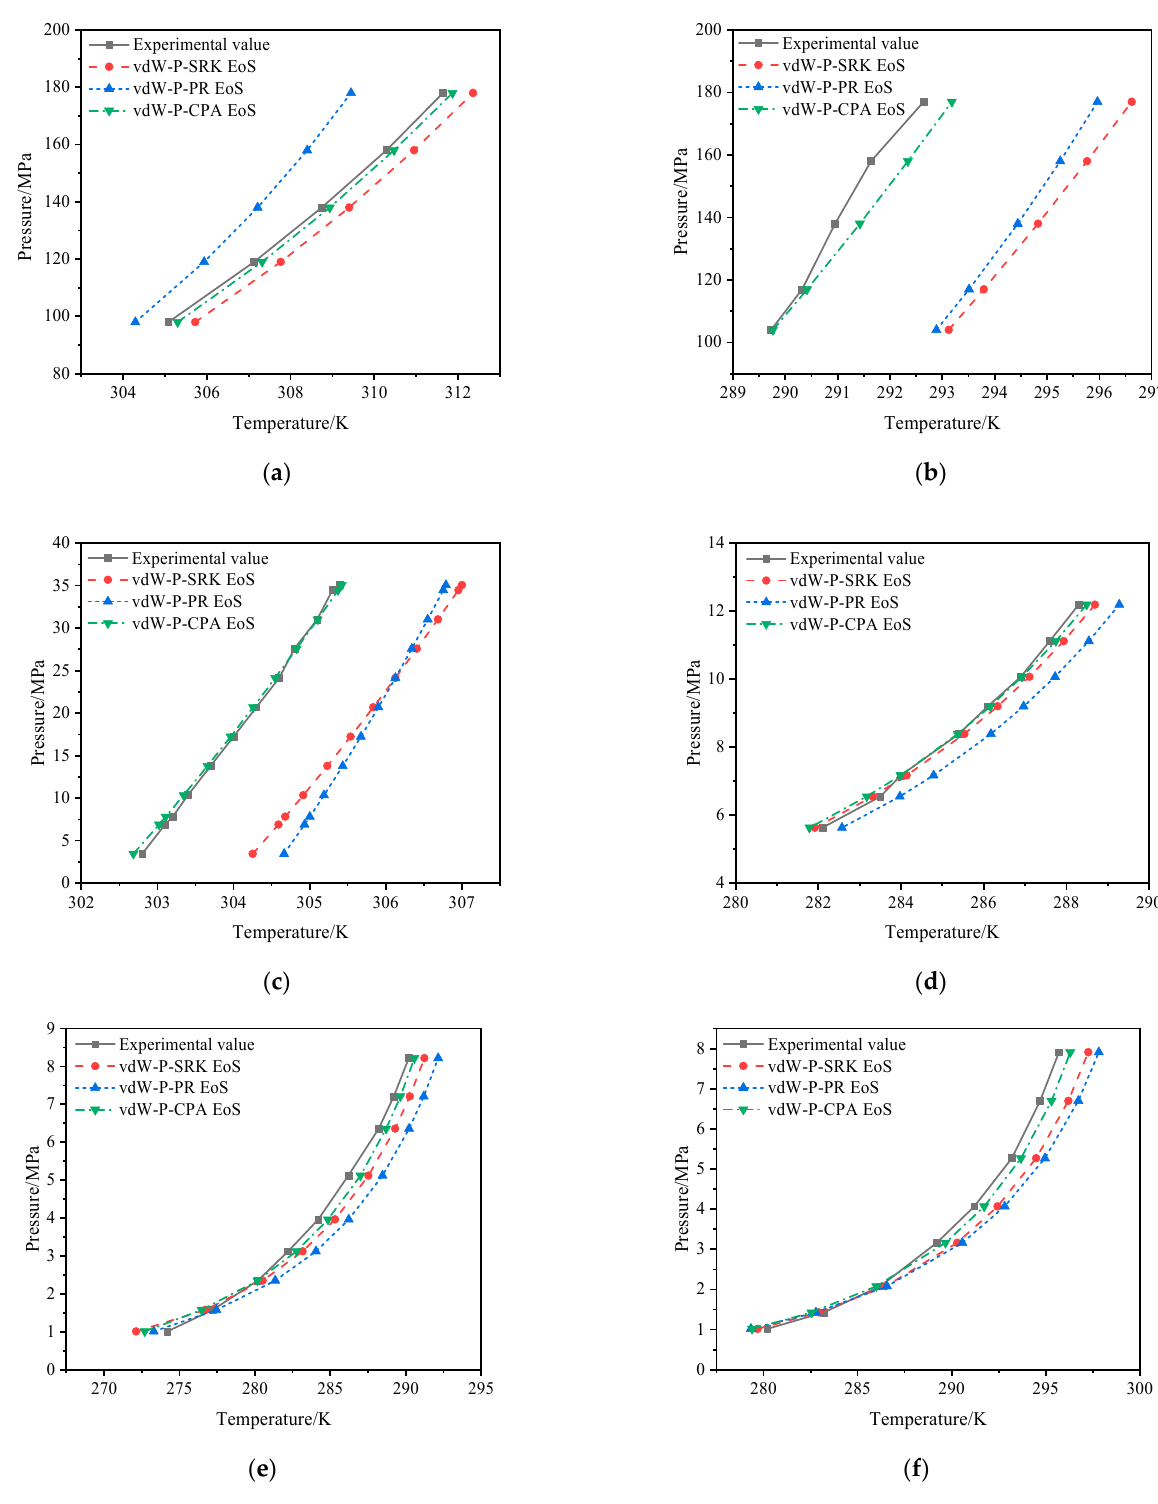
Figure 1. Comparison of hydrate formation conditions predicted based on different models and experimental values for: ( a ) CH 4 -water system; ( b ) CO 2 -water system; ( c ) H 2 S-water system; ( d ) multicomponent systems (0.05 mol% H 2 S); ( e ) multicomponent systems (4.95 mol% H 2 S); ( f ) multicomponent systems (14.98 mol% H 2 S).